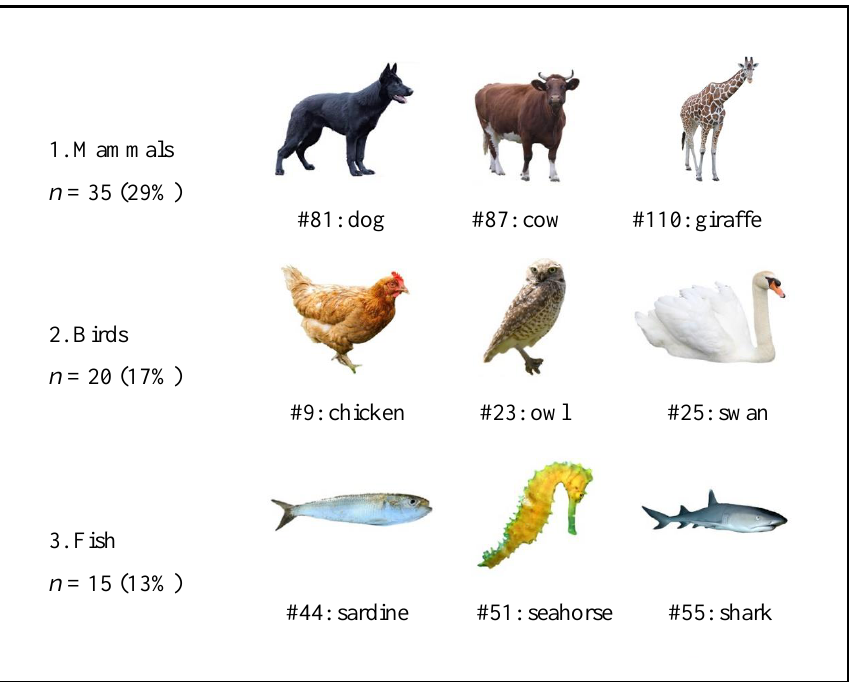
Figure 1. Distribution of the 120 images ( n ; %) according to category and examples of animals included in the stimulus set.